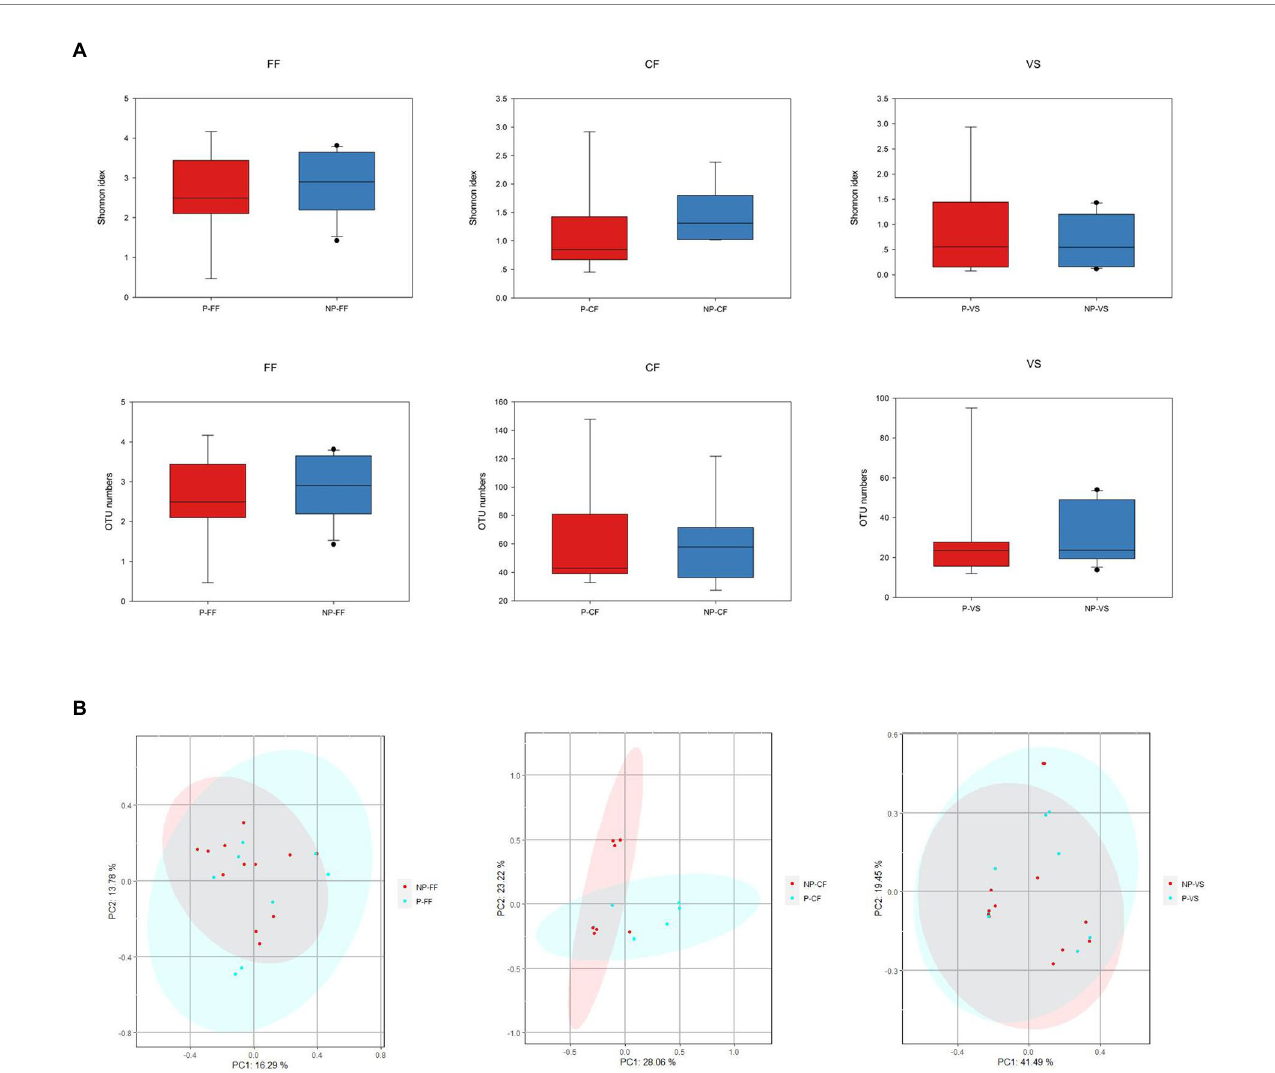
FIGURE 7 Microbial composition and differences of three reproductive tract sites of different pregnancy outcomes. (A) Microbial alpha diversity in Pregnancy and Non-pregnant groups, (B) At the OTU level, PCA analysis showed differences in microbial composition in different parts of the reproductive tract between the Pregnancy and Non-pregnant